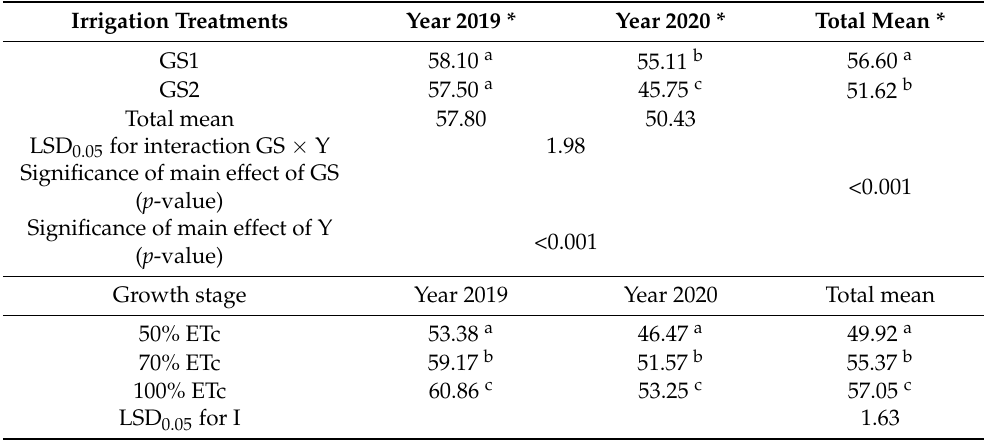
Table 5. Leaf Greenness Index (SPAD) for the two years 2019 and 2020, for two growth stages. Data pre- sented are mean values, where LSD 0.05 is the Least Significant Difference at the 0.05 significance level. Irrigation